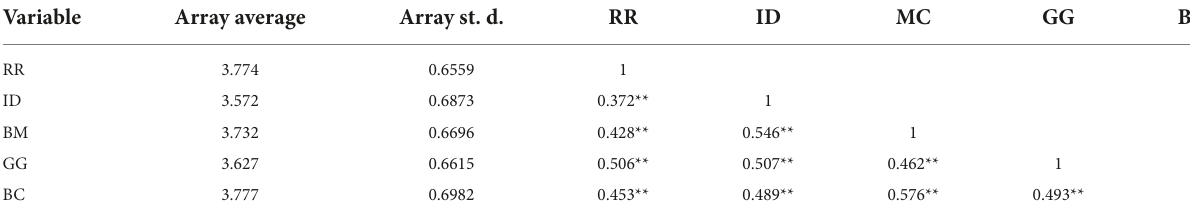
TABLE 5 Descriptive and